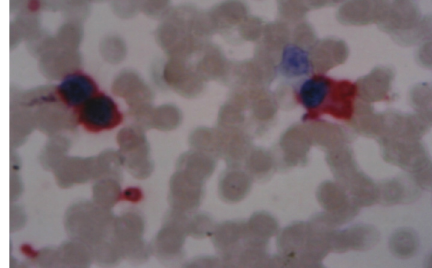
Figure 3: CD61 positivity in blast